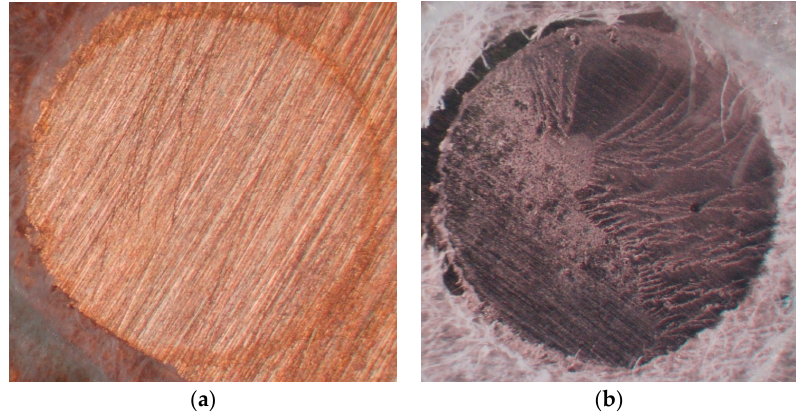
Figure 4. Microscopy image (×45) representative failure. ( a ) adhesive failure at Au–self-cured acrylic resin interface, ( b ) mixed failure of the adhesive failure at Au alloy–self-cured acrylic resin interface and the cohesive failure of self-cured acrylic resin.